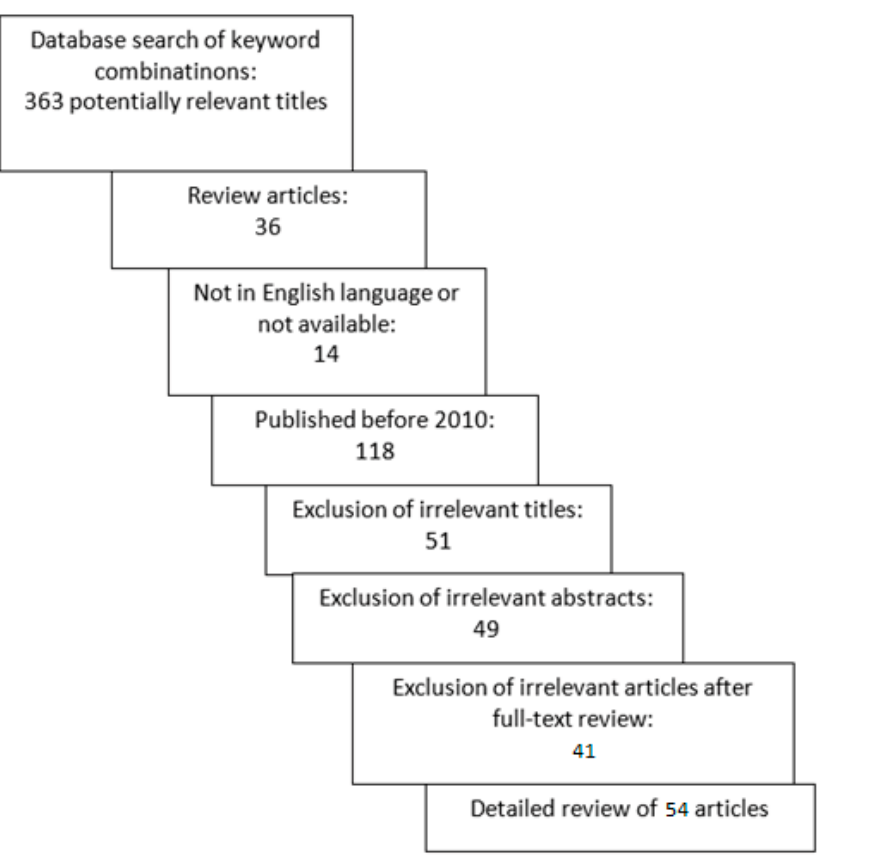
Figure 1. Search process for review of changes of extracellular matrix in cervical and endometrial cancer.